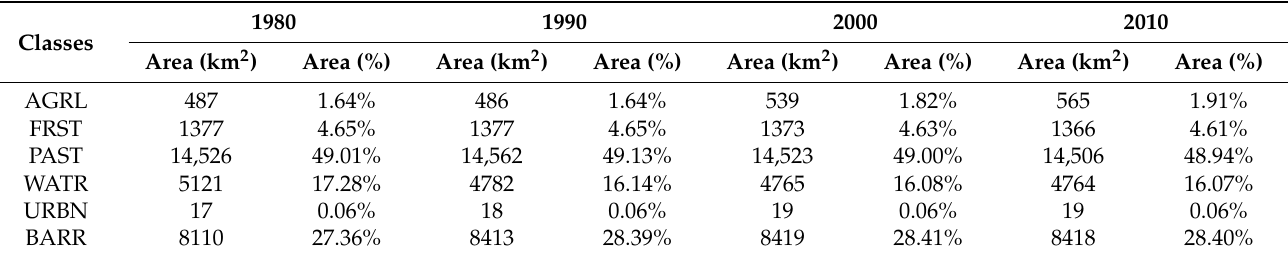
Table 3. Areas and percentage of land use types in the catchment.